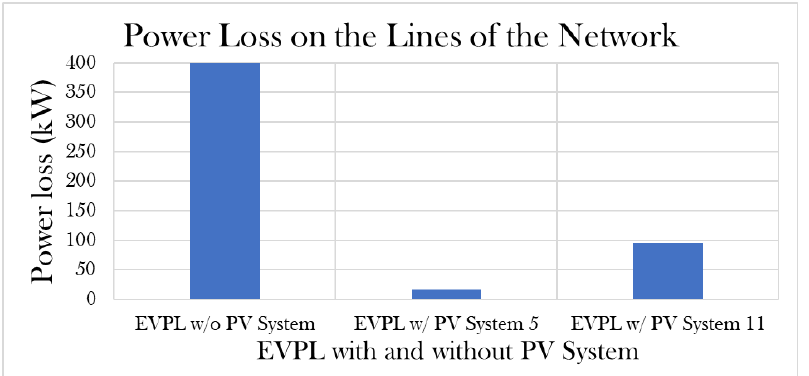
Figure 16. Impact of EVPLs on the power loss on the lines of the distribution